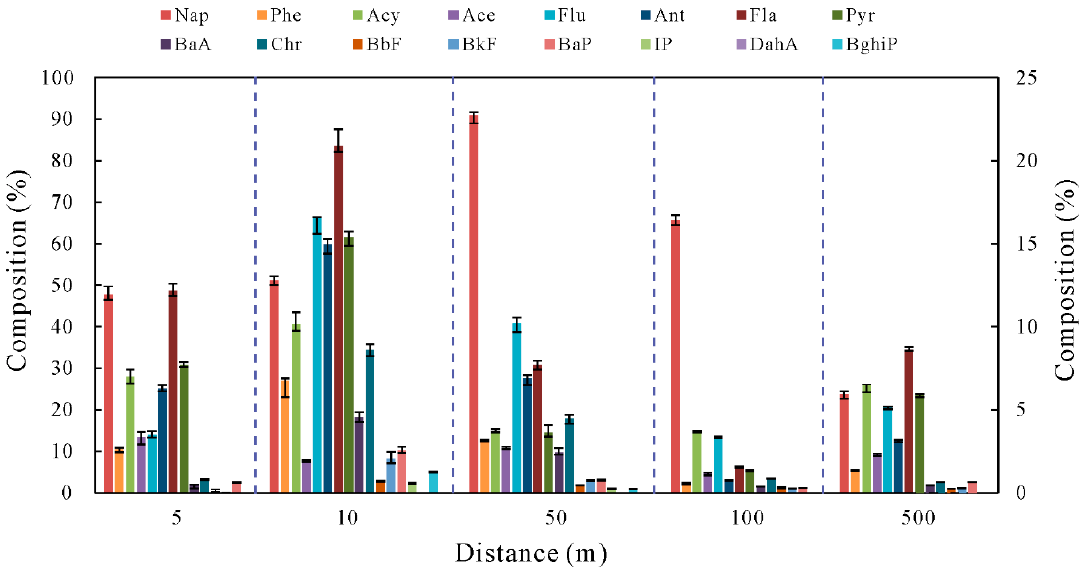
Figure 4. Distribution pattern of PAHs in soils around the coal spoil piles (Nap composition is shown in the left Y-axis, other PAHs composition is shown in the right Y-axis). in the left Y-axis, other PAHs composition is shown in the right